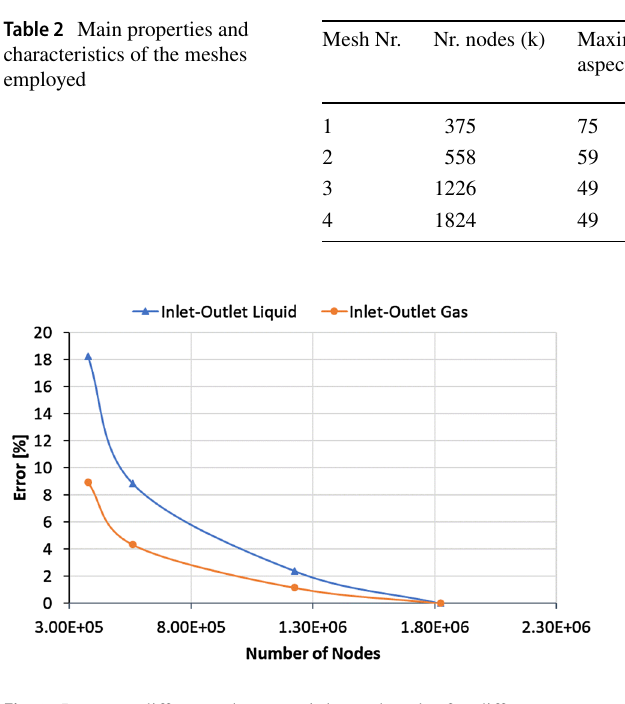
Fig. 3 Pressure difference between inlet and outlet for different num- ber of nodes (mesh independence study)